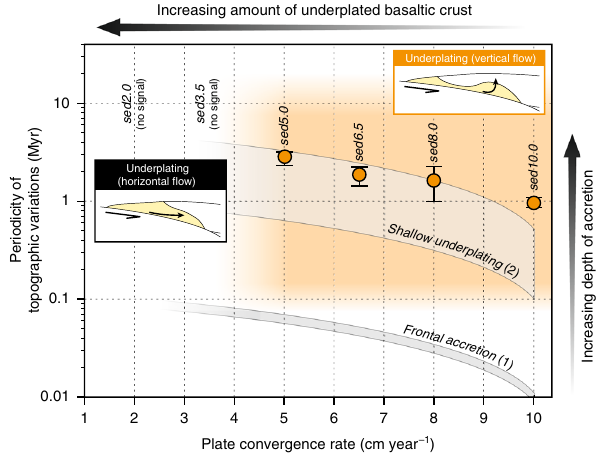
Fig. 4 Anti-correlation between forearc topographic signal and plate convergence. Semi-log chart showing the mean periodicity of vertical topographic oscillations predicted for the forearc domain in our numerical experiments (orange dots with error bars representing one standard deviation). It is noteworthy that the Myr-scale topographic signal is only recorded when tectonic underplating is achieved by an overall vertical mass fl ow (orange-shaded area) as predicted in faster-subduction numerical experiments. Alternatively, an overall horizontal mass fl ow at the base of the forearc domain for slow subduction does not result in signi fi cant vertical topographic variations (see Supplementary Note 3 for details). Grey-shaded curves characterize vertical forearc topographic variations from time-unscaled analogue experiments focusing on (1) frontal accretion 40 and (2) shallow tectonic underplating 35 (i.e., 16 – 18 km depth).